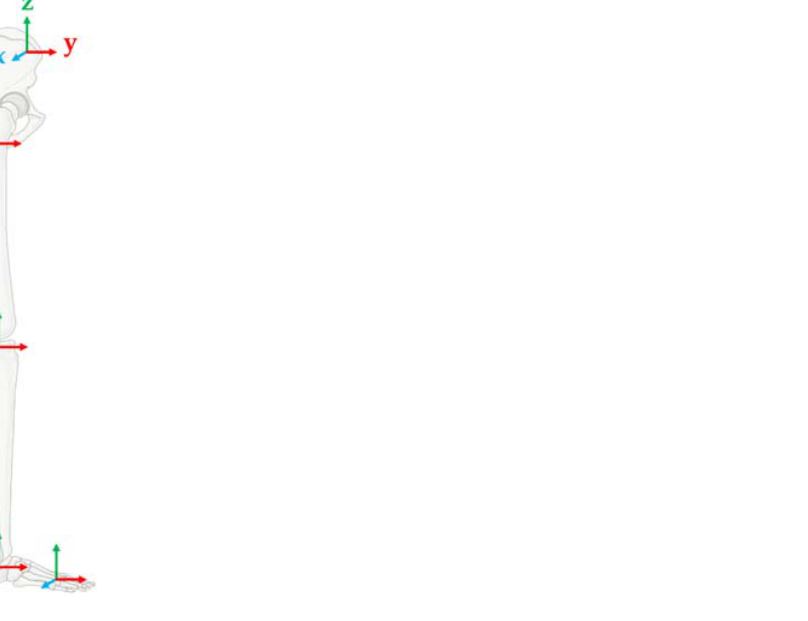
Figure 3. Reference systems for the pelvis body and the lower limb.